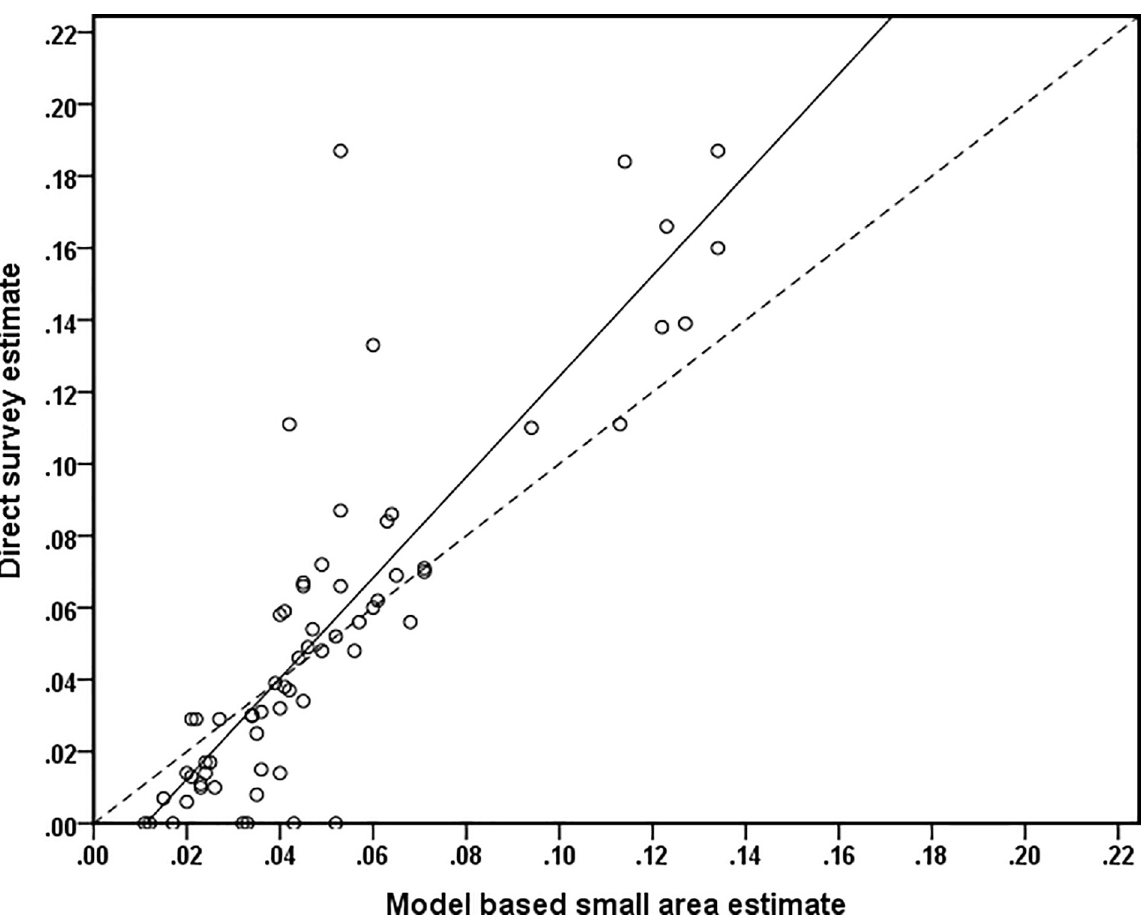
Fig 6. Bias diagnostic plot with y = x line (dotted) and regression line (solid) for diarrhoea prevalence (%) in Bangladesh.